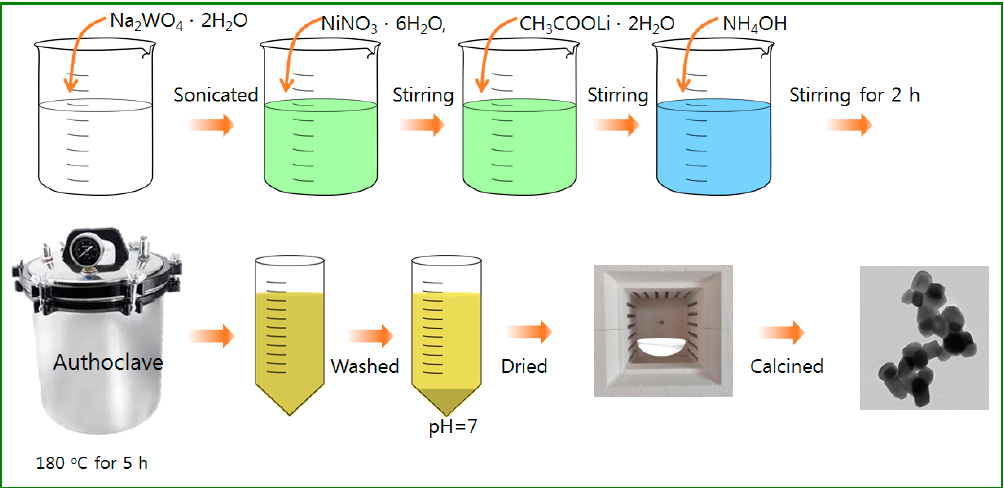
Figure 10. Synthesis of Ni 1-x Li 2x WO 4 particles by the hydrothermal method.